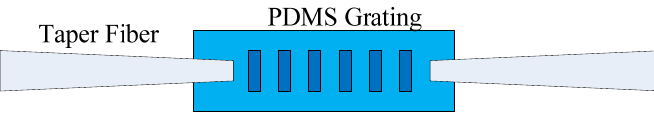
Figure 5. The schematic diagram of LPFG made up of PDMS [31].